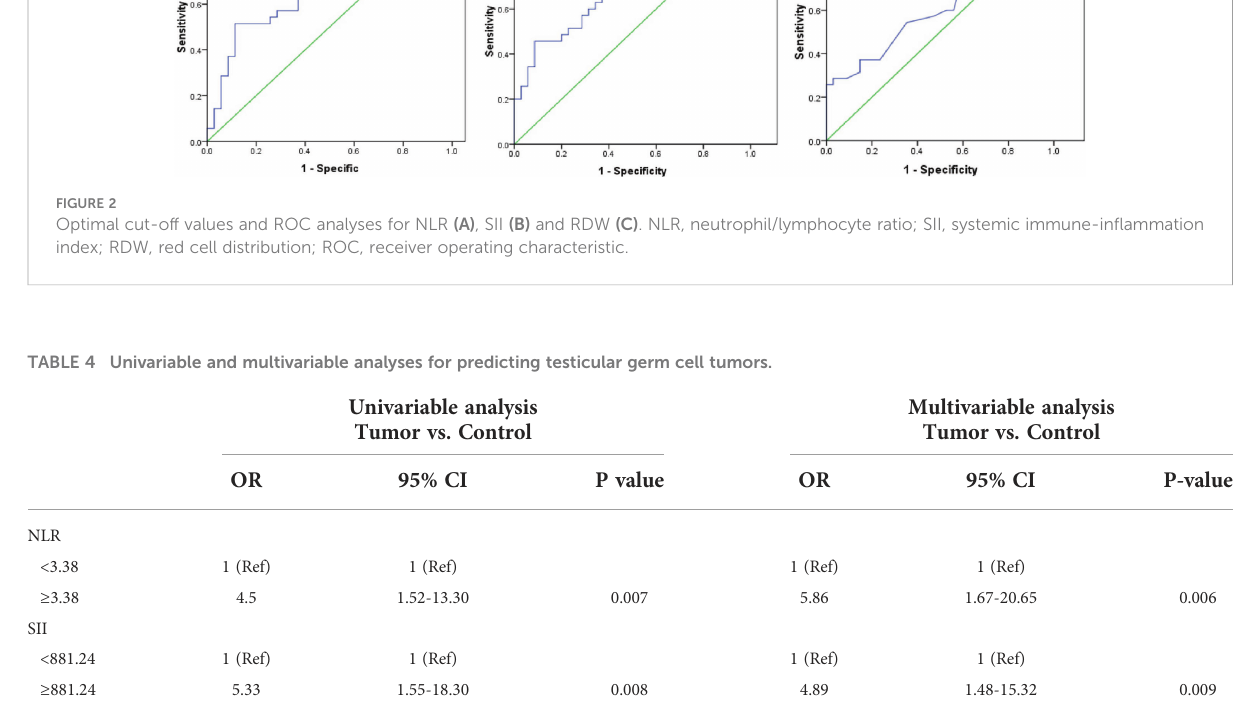
values (<881.24 and ≥ 881.24) are shown in Table 6. Signi fi cantly Statistical difference of pathological stage was found between groups with respect to NLR cut-off values (P=0.034) and SII cut- off values (P=0.049), when NLR ≥ 3.38 or SII ≥ 881.24 more patients are with stage II and stage III. There was no signi fi cantly difference of age between groups.